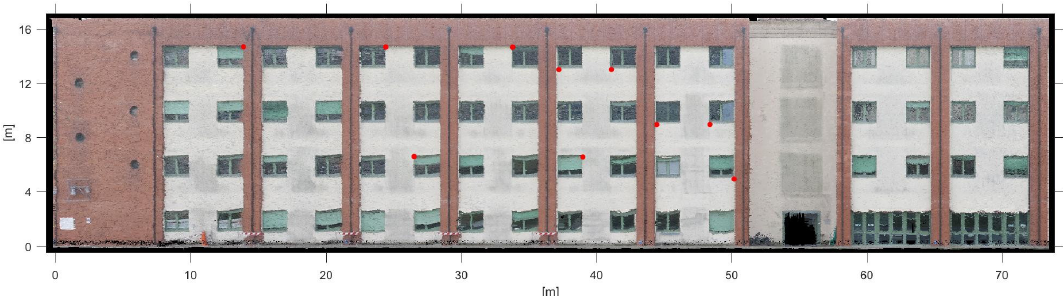
Figure 4. Control points on the building façade considered for vision-aided